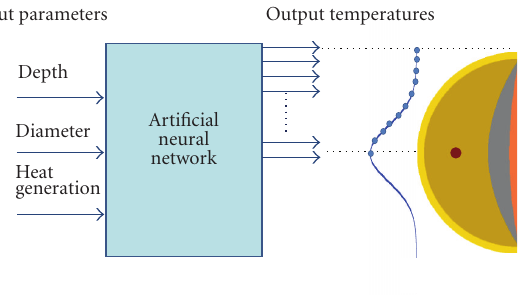
Figure 2: Schematic of the neural network.